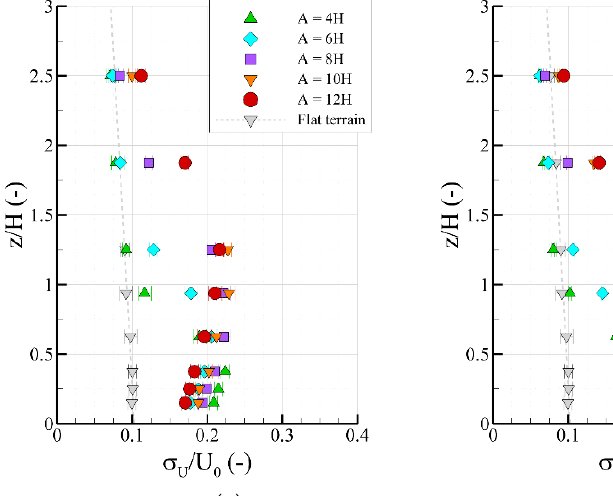
( c ) Figure 8. Semilogarithmic vertical profiles of the normalized horizontal ( a ) and vertical ( b ) turbulent fluxes above the crests of the second ridges; Logarithmic vertical profiles of the normalized longitudinal integral length scales above the crests of the second ridges ( c ).